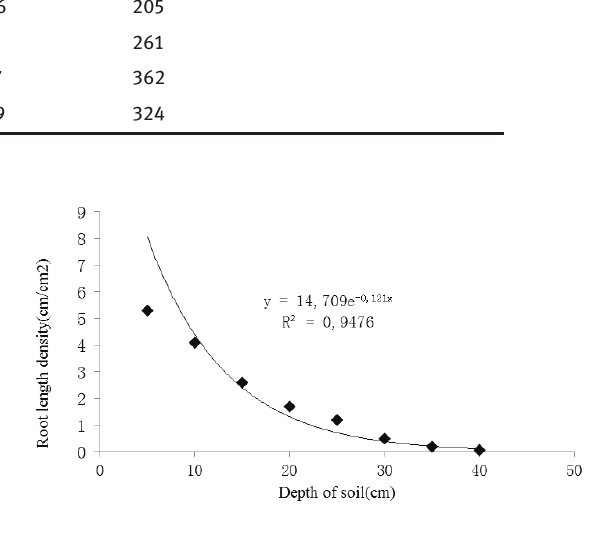
Figure 10: Density distribution of root system with soil depth.